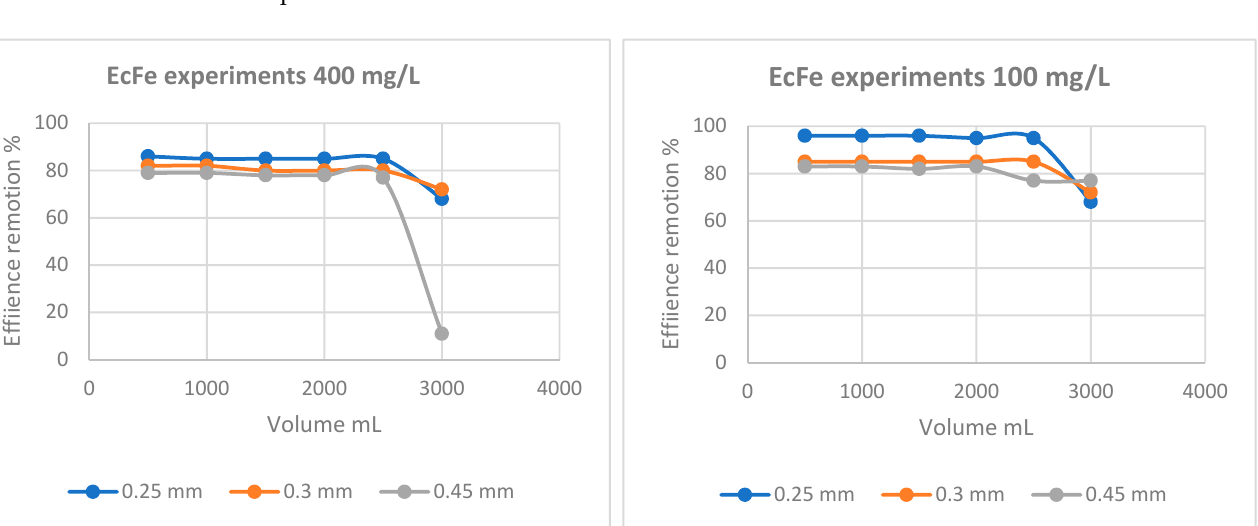
Figure 9. Treatment with (EcFe) experiments of 400 mg/L and 100 mg/L.